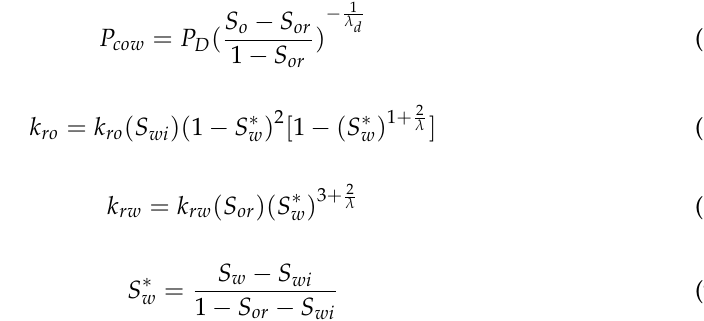
where P D is the pore entry pressure; S or is the residual oil saturation; λ d is equal to 1.6; S wi is the irreducible water saturation; S ∗ is the dimensionless water saturation; λ is a shape w factor between 2.0 and 4.0. The boundary and initial conditions are set identically to the conditions in the physical experiment. The fitted parameters are given in Table 1. The volume of cumulative produced oil and the pressure drop between two wells obtained in physical experiment and numerical simulation are given in Figure 13. The oil saturation distribution during displacement is shown in Figure